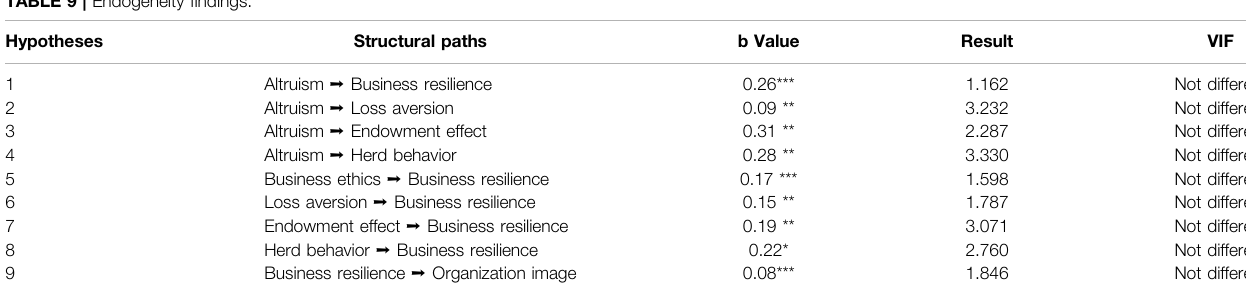
TABLE 9 | Endogeneity fi